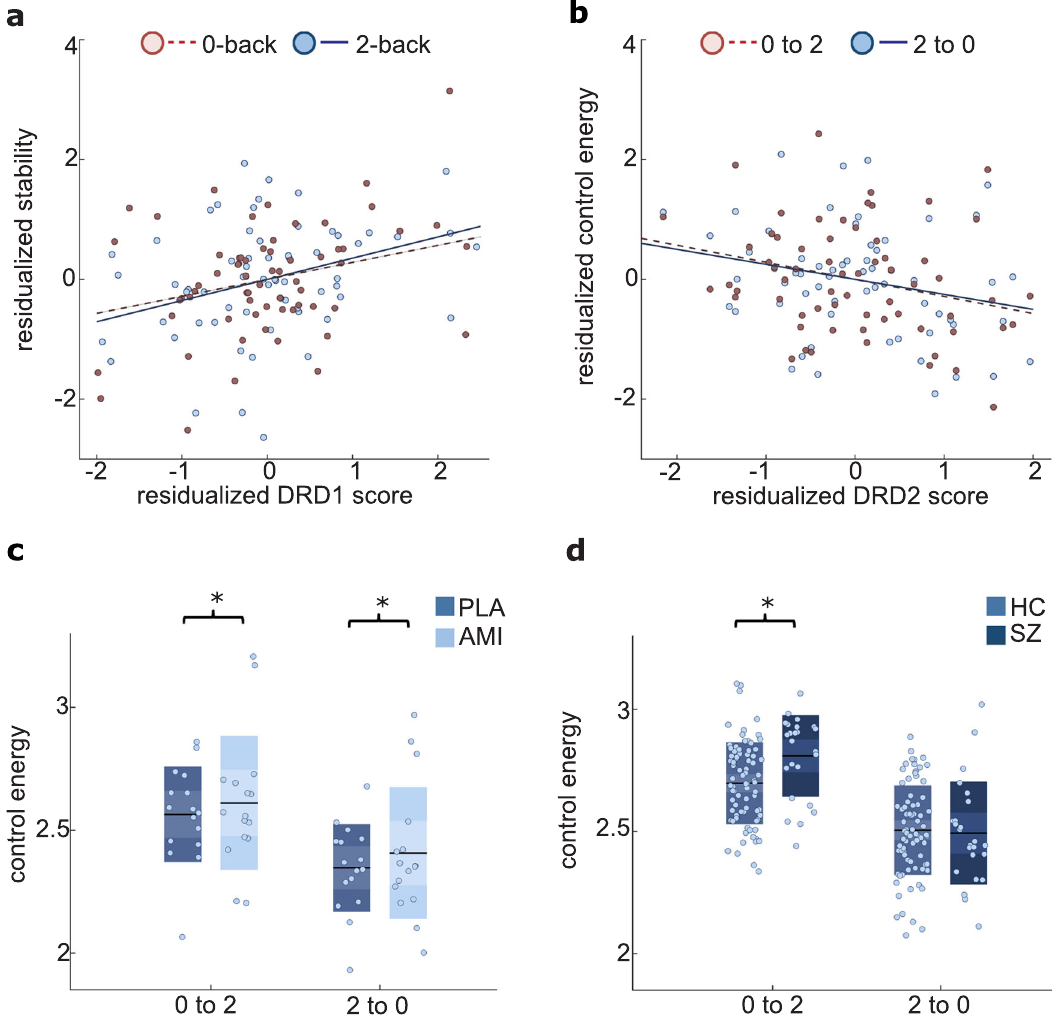
Fig. 3 Dopamine receptor expression and pharmacological modulation impact whole-brain dynamics. a Genetic scores predicting DRD1 expression in prefrontal regions positively predict stability of both brain states (0-back: b = 0.184, p = 0.034; 2-back: b = 0.242 p = 0.007; age, sex, mean brain state activity, and fi rst 5 genetic PCA components as covariates of non-interest). b Genetic scores predicting DRD2 expression in prefrontal regions negatively predict control energy for both brain state transitions (0-back to 2-back: b = − 0.076, p = 0.037; and trend wise for 2-back to 0-back: b = − 0.134, p = 0.068; age, sex, mean brain activity difference, and fi rst 5 genetic PCA components, stability of 0-back and 2-back as covariates of non-interest). c Amisulpride (AMI) increases control energy for transitions in comparison to placebo (PLA) (main effect of drug: F (1,10) = 7.27, p = 0.022; interaction drug by condition: F (1,10) = 0.42, p = 0.665, activity difference, drug order, and sex as covariates of non-interest). Black lines indicate mean values and boxes indicate one standard deviation of the mean. d Individuals with schizophrenia (SZ) need more control energy when transitioning into the working memory condition than matched healthy controls (HC) ( F (1,98) = 5.238, p = 0.024, age, sex, tSNR and mean activity as covariates of non-interest), but not vice versa. Black lines indicate mean, dark boxes indicate 1 standard deviation, light boxes indicate 1.96 SEM. Source data are provided with this